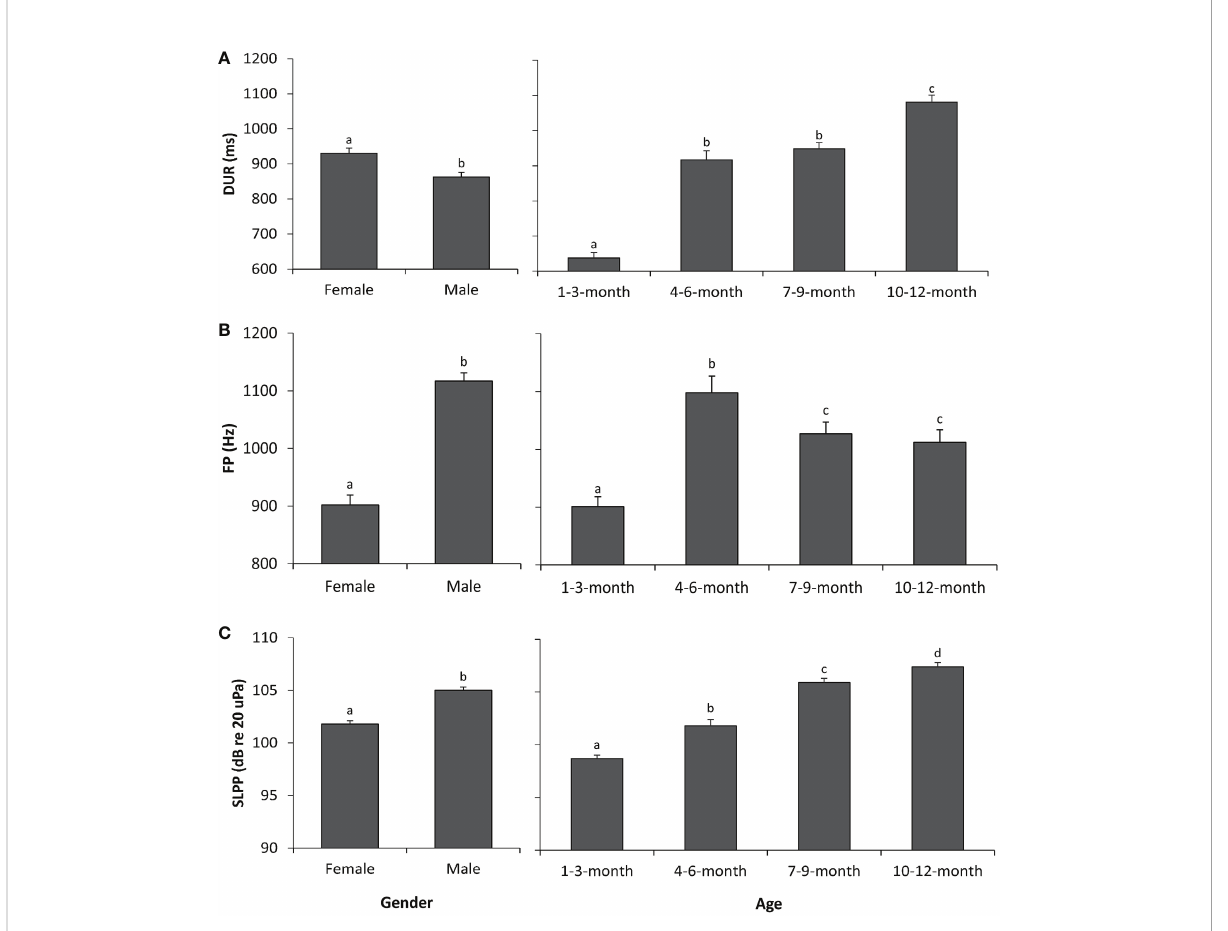
FIGURE 1 Sex and age effects on the sound parameters of spotted seal pups. (A) Duration (DUR). (B) Peak frequency (FP). (C) Peak-to-peak source level (SLPP). Different lowercase letters (i.e., a, b, c, and d) on each bar indicate signi fi cant statistical differences between groups, whereas groups with the same letter indicate no statistical difference. A p -value < 0.05 is considered statistically signi fi